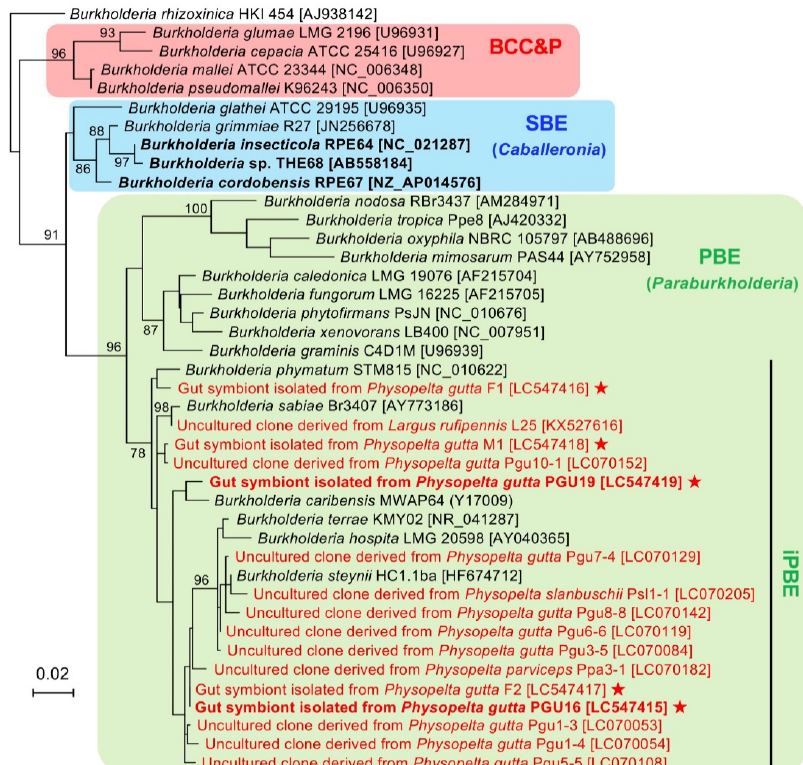
Figure 2. Molecular phylogeny of the Burkholderia symbionts isolated from P. gutta based on 16S rRNA gene. The tree shows an ML phylogeny of the five isolates and related species / clones of the genus Burkholderia sensu lato. The multiple sequence alignment of 1320 nucleotide sites of the bacterial 16S rRNA gene was analyzed. Accession numbers in the DDBJ / EMBL / GenBank DNA database are shown in square brackets. The isolates and uncultured clones of symbiotic Burkholderia derived from largid stink bugs are shown in red. Stars indicate the isolates reported in this study. Bold indicates the Burkholderia symbionts of stink bugs with complete genome sequences. Bootstrap support values higher than 70% are shown on the internal branches. BCC&P, Burkholderia cepacia complex and Burkholderia pseudomallei clade; SBE, stink bug-associated beneficial and environmental clade; PBE, plant-associated beneficial and environmental clade; iPBE, insect-associated PBE